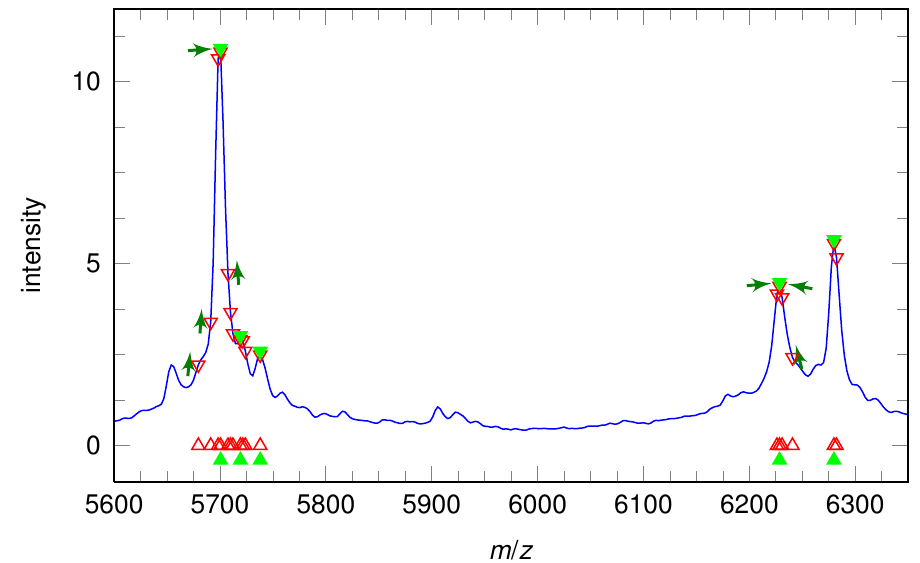
Figure 2: The method from [5] of alignment of data set frequent masses. The data set mean spectrum is shown in blue. Red triangles indicate peaks (and their masses) found after peak picking. Green arrows illustrate the process of alignment. Green triangles show aligned peaks and their masses. Reprinted from [5], Copyright 2011, with permission from